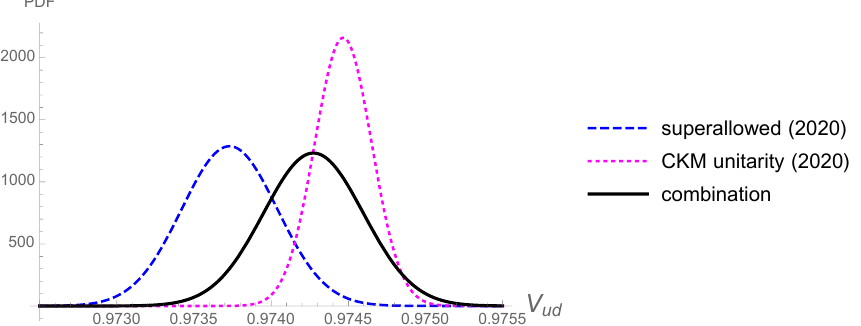
Figure 1 . Combination of values of V ud extracted from super-allowed decays and unitarity